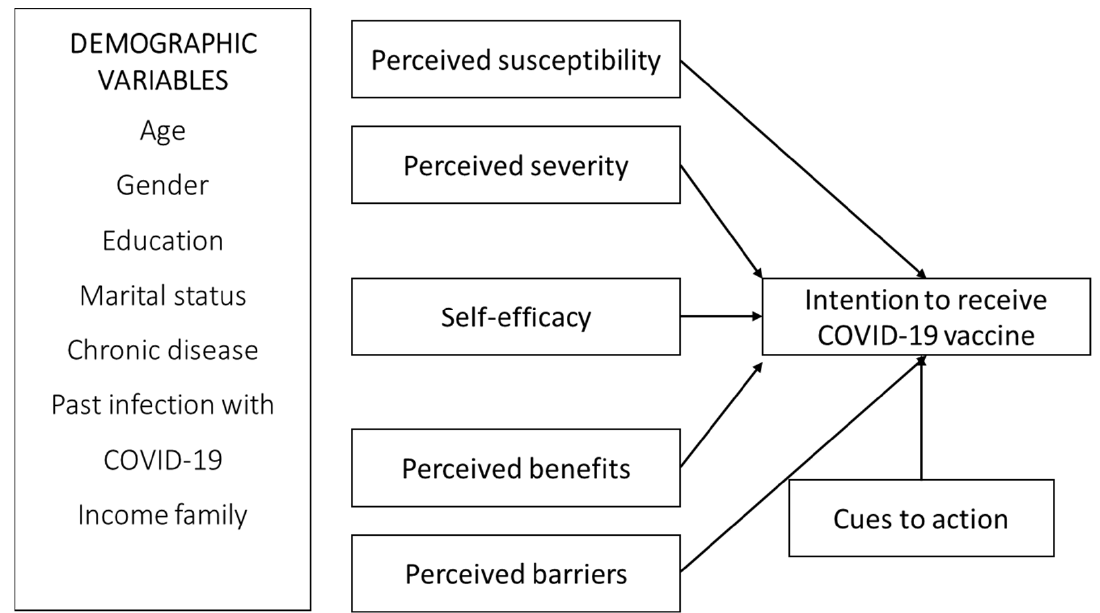
Figure 1. Theoretical framework.